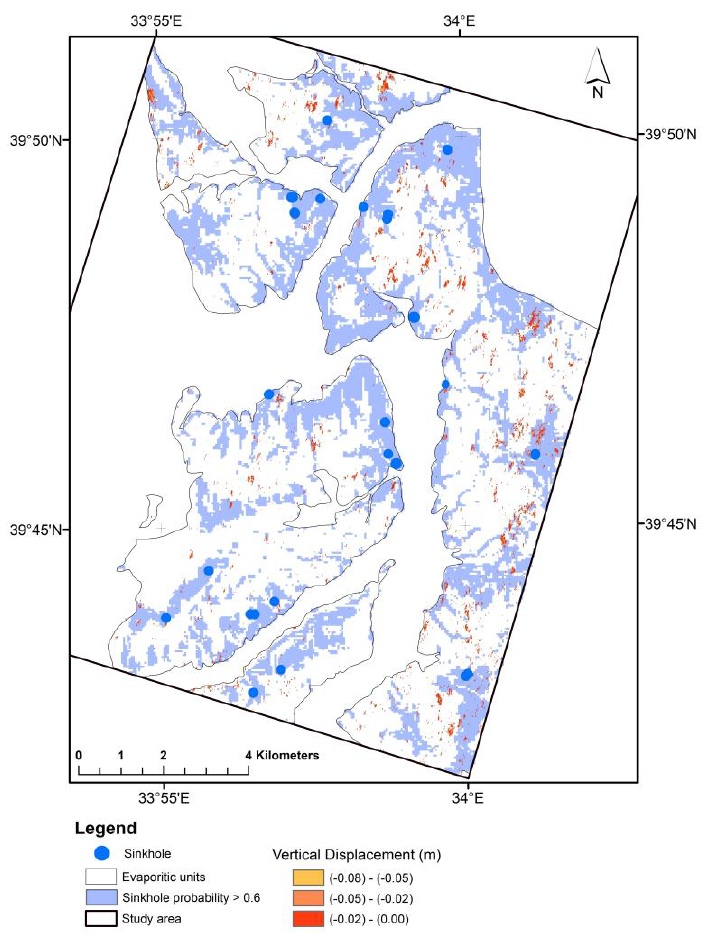
Figure 10. Superimposition of the maps, sinkhole inventory, observed vertical deformation, and sinkhole susceptibility, indicating the most critical conditions in terms of railway route selection in the study